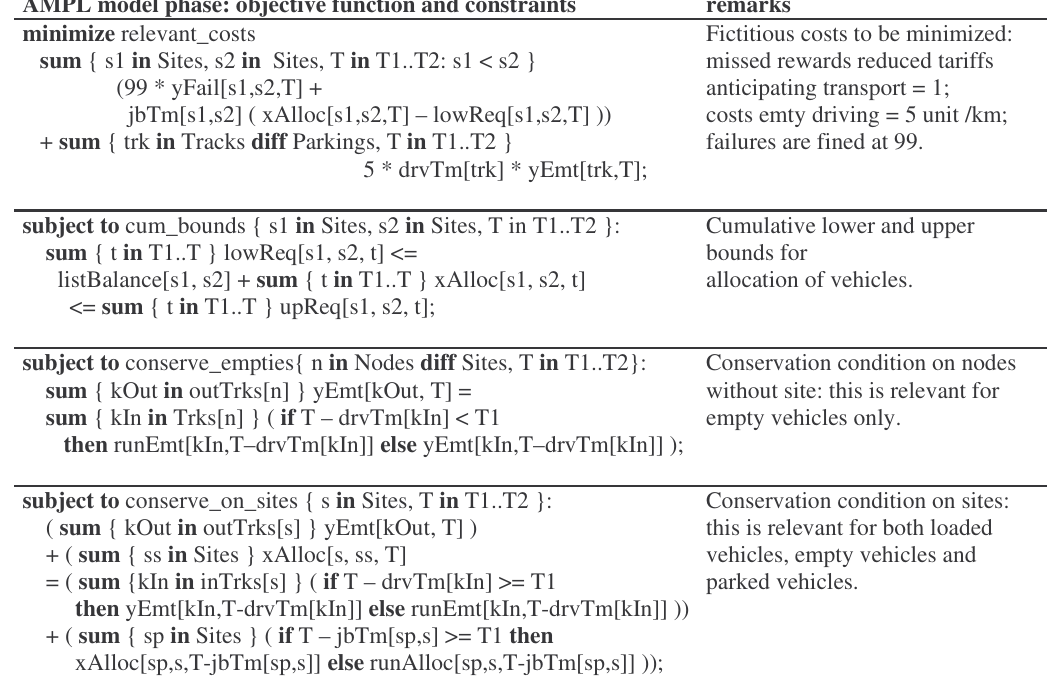
Table 3. Objective functions and constraint of the AMPL model (without capacity constraints) AMPL model phase: objective function and